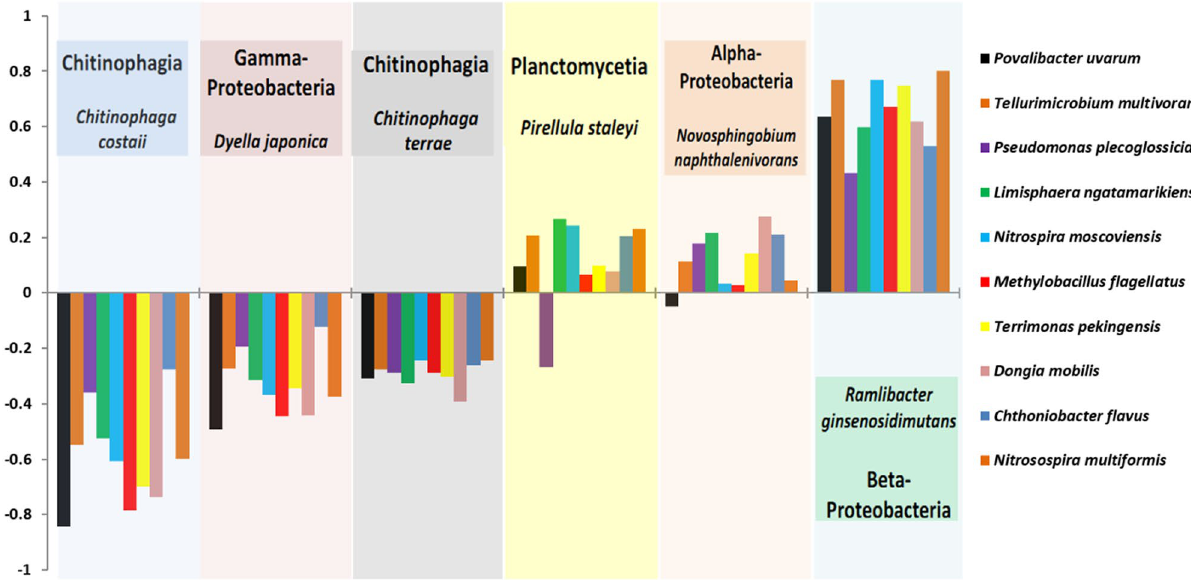
Figure 7. Histograms representing 10 positively and negatively co-occurring microbial species in response to C. costaii, C. terrae, D. japonic a, P. staleyi, N. naphthalenivorans and R. nginsenosidimutans species found in the rhizo-compartments of both E. plantagineum (EP) and L. erythrorhizon